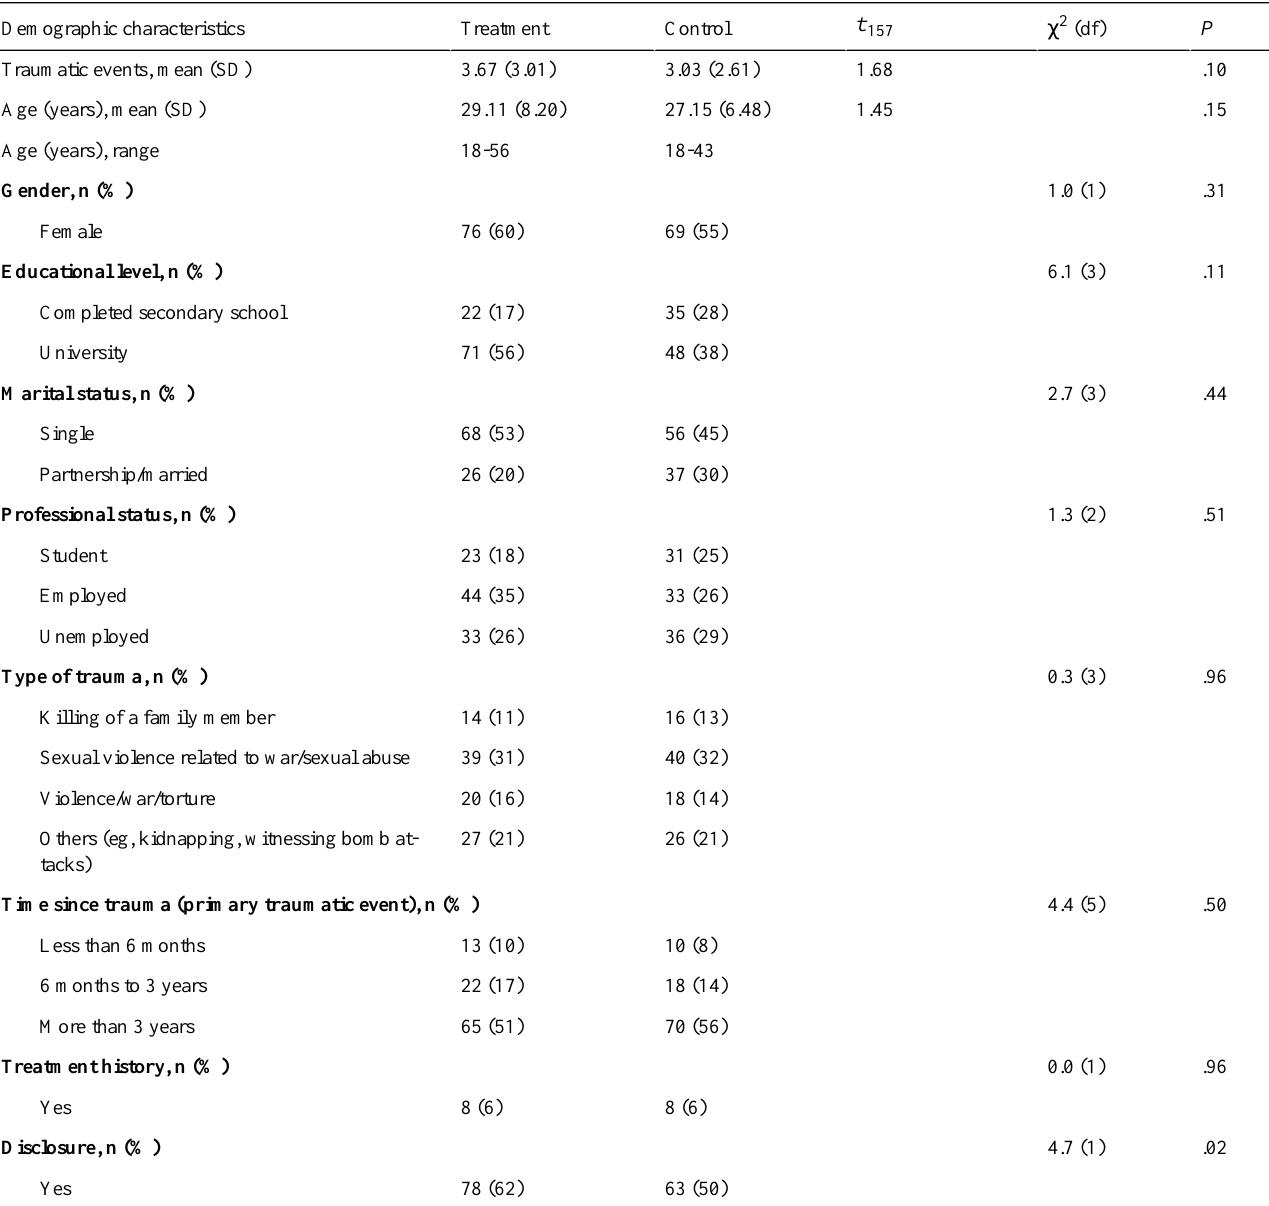
Table 1. Demographic and descriptive characteristics of the treatment and waiting list control groups at baseline